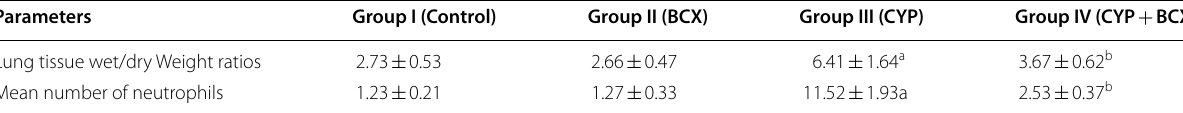
Table 4 The mean values of lung tissue wet/dry weight ratios and mean number of neutrophils in the different studied groups